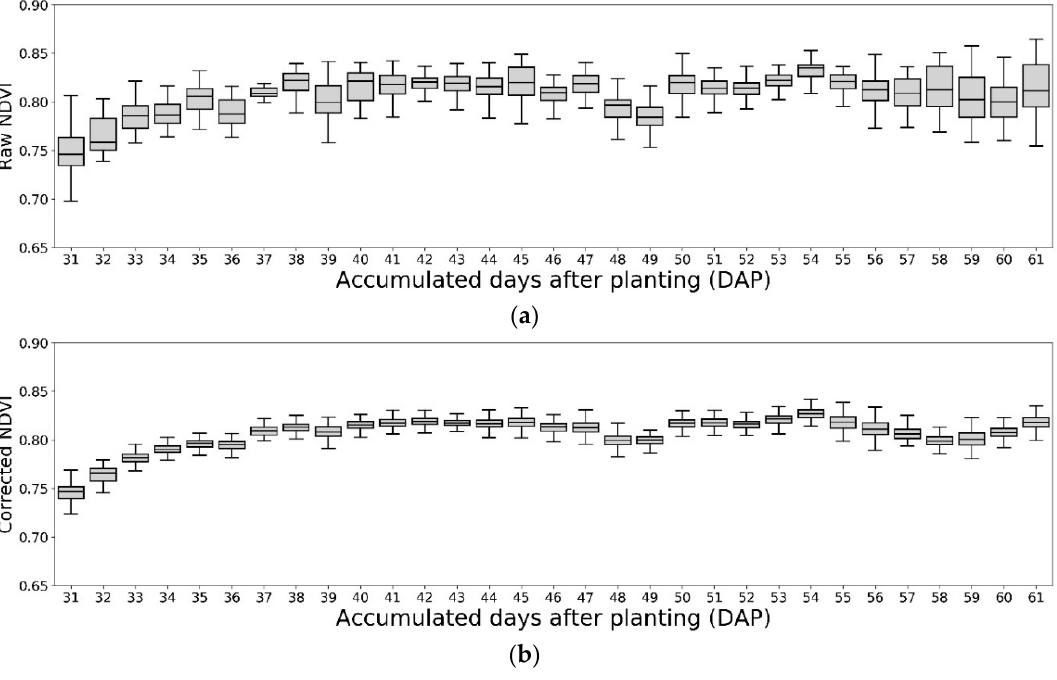
Figure 6. Box plots for the five-fold cross-validated correction result of the sample dataset (G1H). ( a ) The raw NDVI with huge daily variances across 31 days. ( b ) The ANN model corrected NDVI with much more condensed boxes.